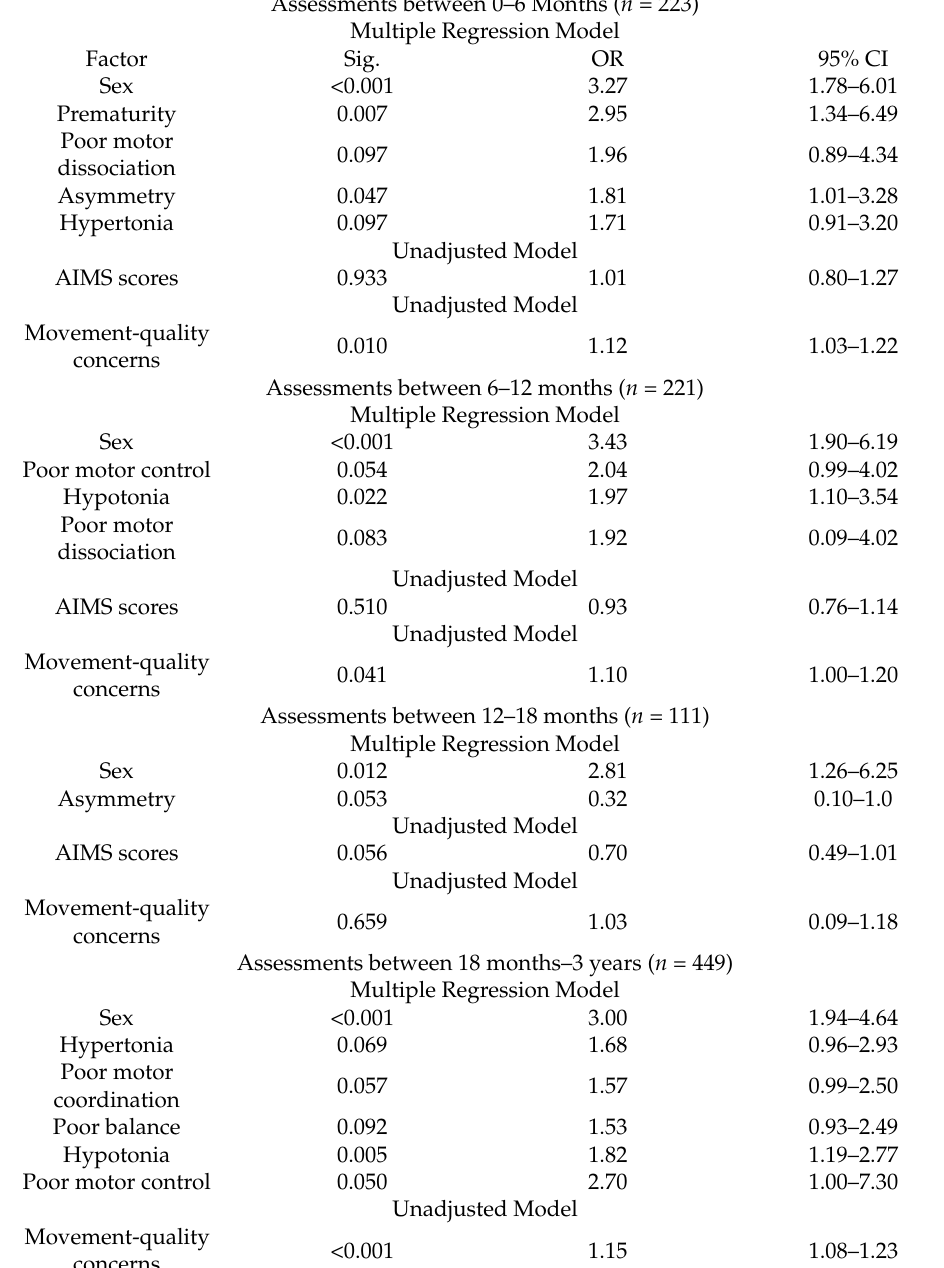
Table 4. Results of Multiple Binary Logistic Regression Analyses to Associate Deviant Movement- Quality Categories (<3 years), Prematurity and Sex with a DCD Diagnosis (>3 years), and Unadjusted Binary Logistic Regression Models to Associate AIMS Scores (<3 years) and “Movement-Quality Concerns” (<3 years) with a DCD Diagnosis (>3 years). Only results with a significance level < 0.10 are reported. Results with a significance level <0.05 are in